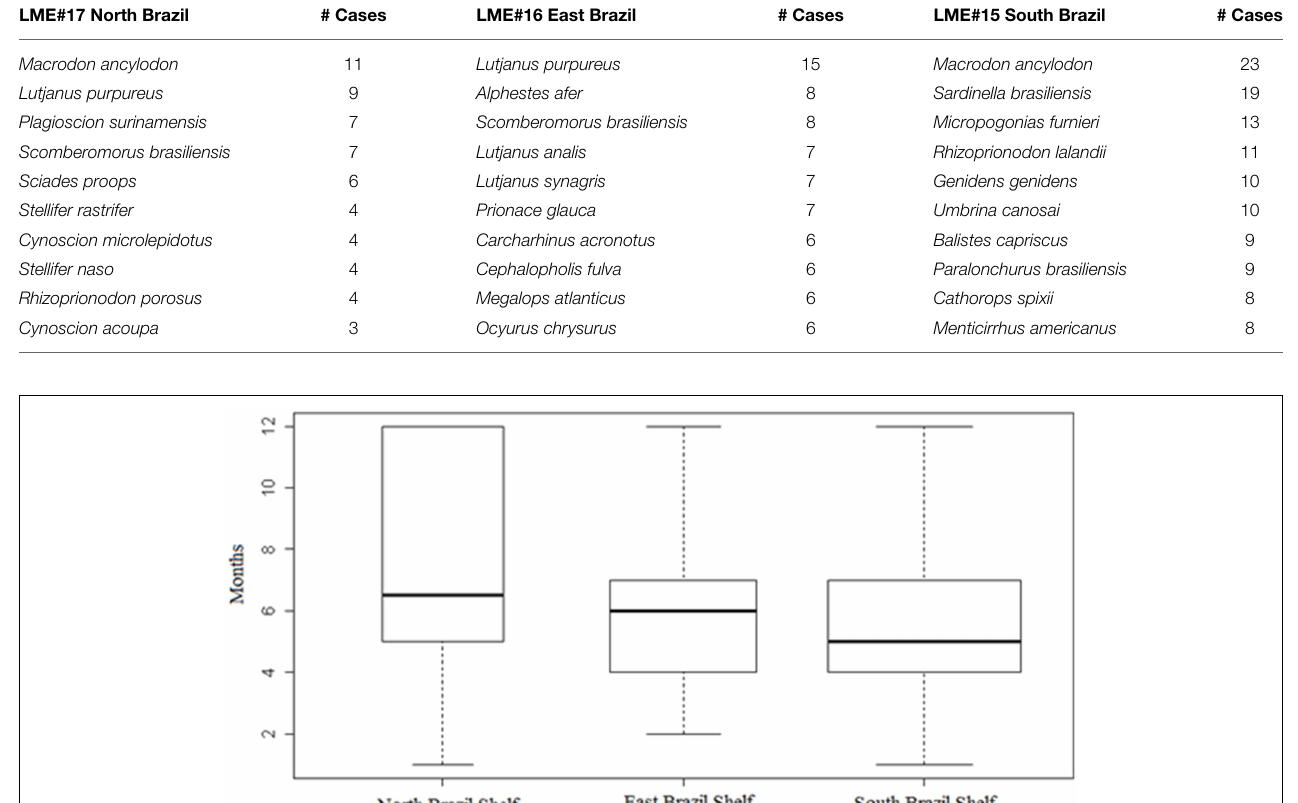
FIGURE 5 | Number of months over which the spawning season extends for Brazilian marine fishes. Horizontal central lines show medians, boxes correspond to the interquartile range, and whiskers are maximum and minimum values.